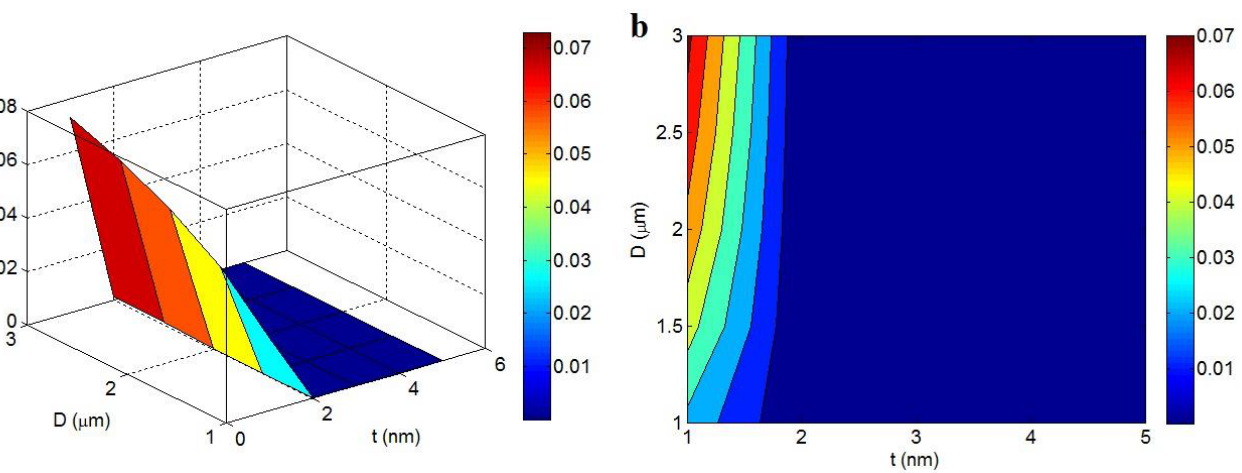
Figure 8. ( a ) Three-dimensional and ( b ) two-dimensional charts for the characters of “t” and “D” in the